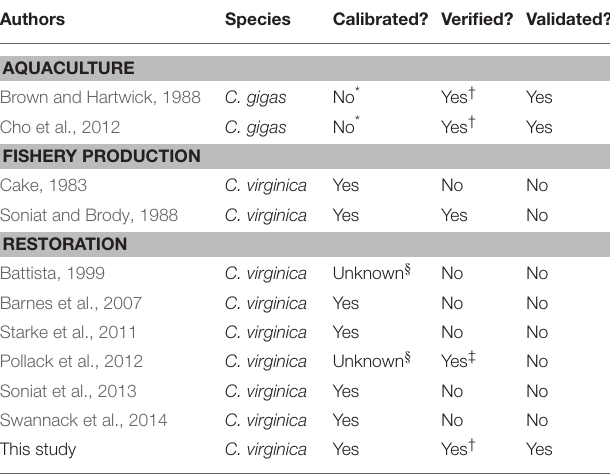
TABLE 1 | Habitat suitability index models developed for oyster aquaculture, fishery production, and